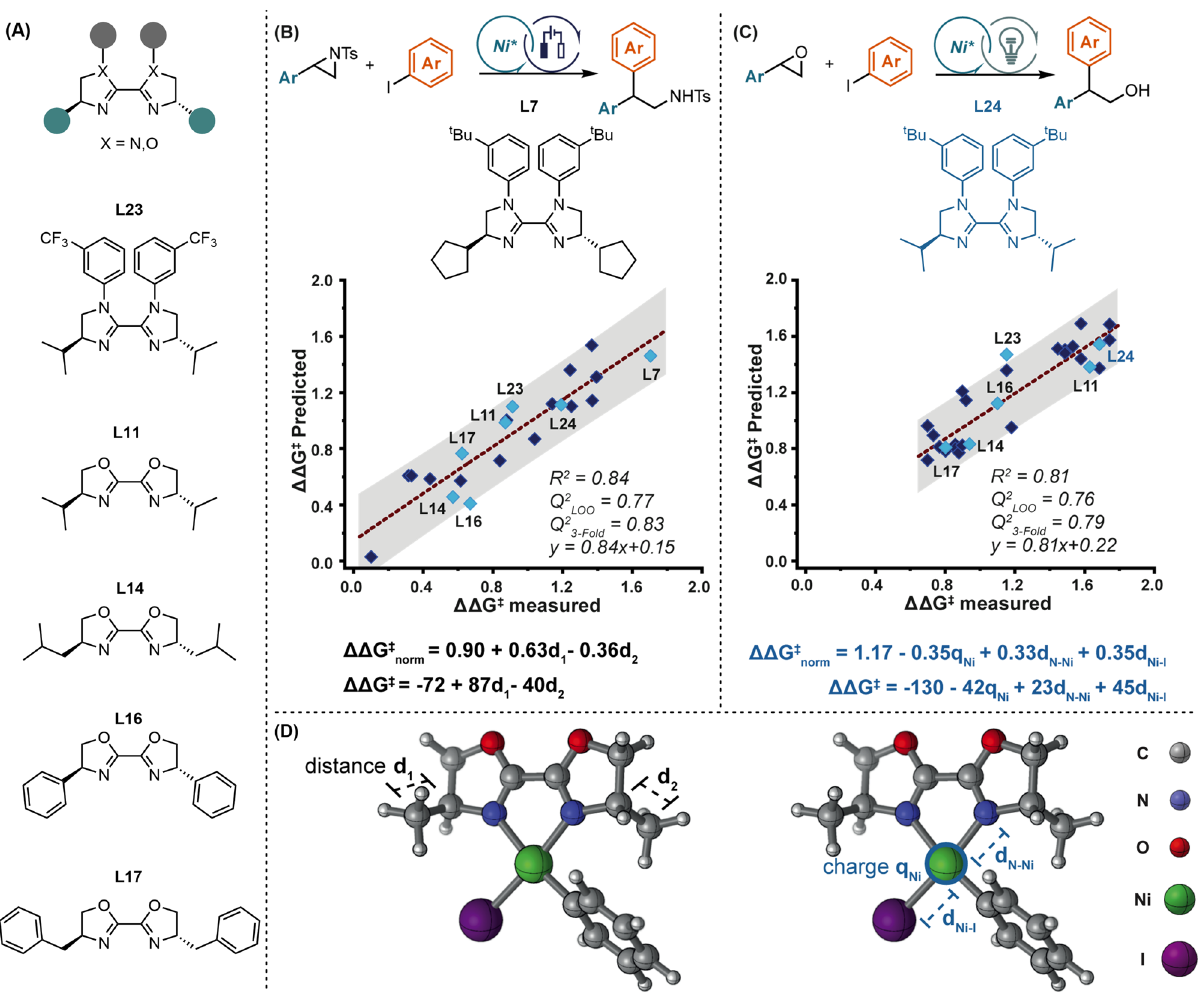
Fig. 6 | Computational and statistical analysis. A Examples of ligands used in both studies. B Model for the electrochemical reaction. C Model for the photochemical reaction. D 3D representation of the